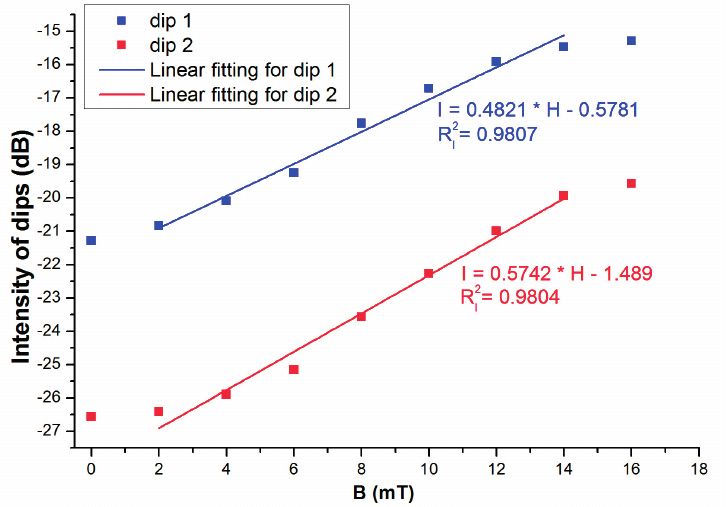
Figure 5. Intensities of dip 1 and dip 2 as functions of magnetic field.